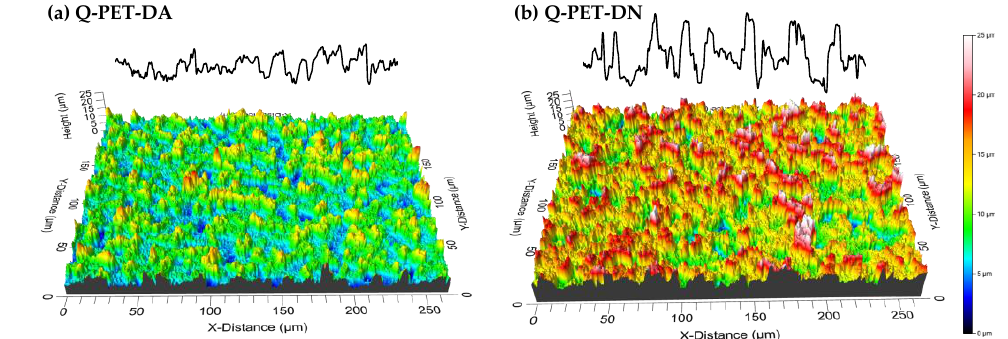
Figure 6. 3D images and profiles obtained by optical profilometry of surfaces where the PET skin was removed by acetone spraying, Q-PET-DA ( a ), and by NaOH solution, Q-PET-DN ( b ).